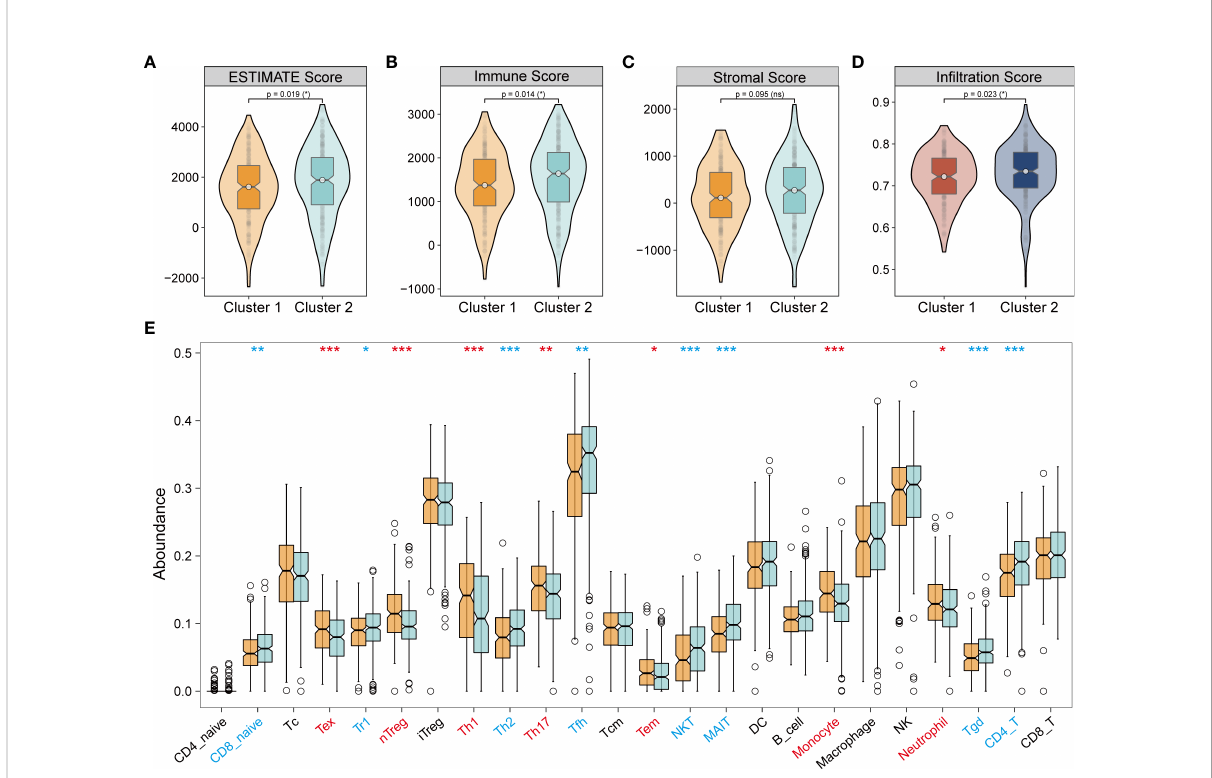
FIGURE 6 Tumor immune in fi ltration in unsupervised clusters. (A – C) ESTIMATE algorithm reveals that cluster 1 has a lower ESTIMATE and immune score compared with cluster 2. (D) ImmuneCellAI algorithm reveals that cluster 1 has lower immune in fi ltration compared with cluster 2. (E) ImmuneCellAI algorithm reveals immune cell abundance across clusters 1 and 2 (Red refers to signi fi cantly highly expressed in clusters 1, blue refers to signi fi cantly highly expressed in clusters 2). *P < 0.05; **P < 0.01; ***P < 0.001; ns, P ≥